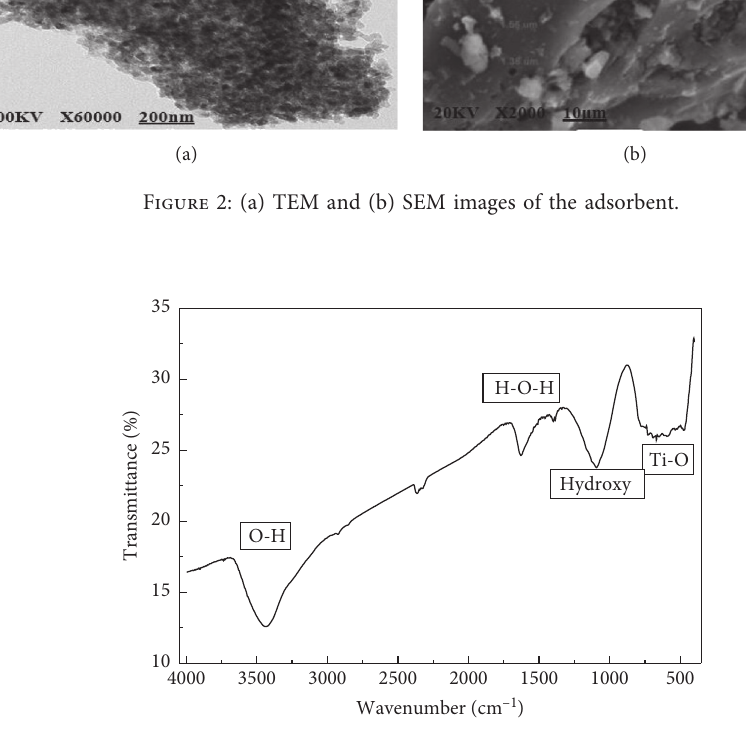
Figure 3: The infrared spectra of the adsorbent.